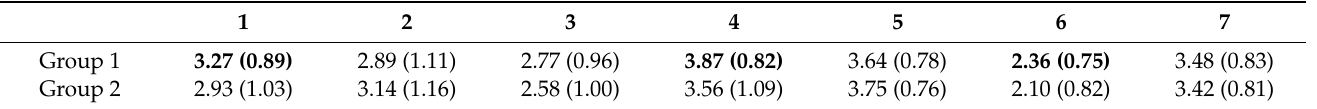
Table 5. Mean scores of the dependent variables for the two